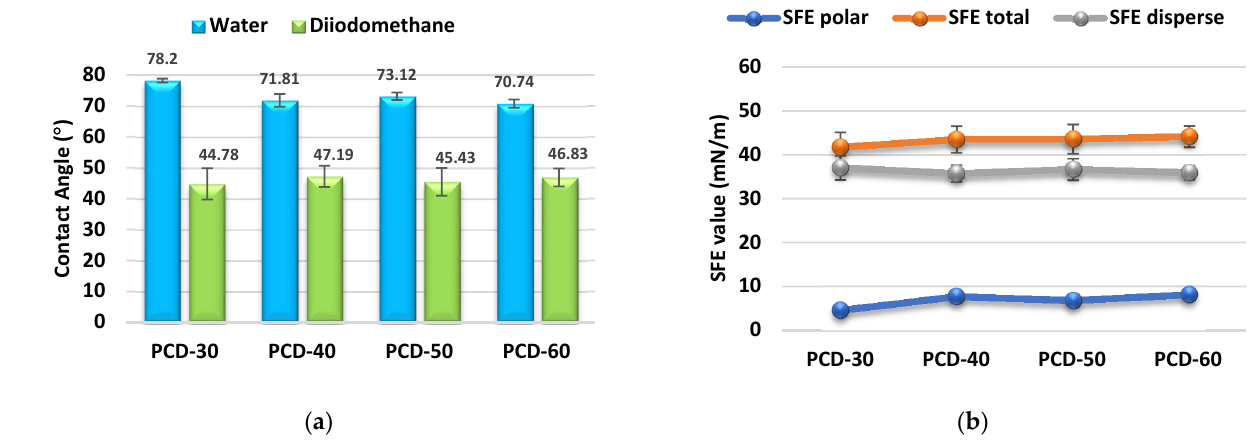
Figure 4. Quantifying the contact angles of ( a ) and SFE ( b ) of synthesized polymers.